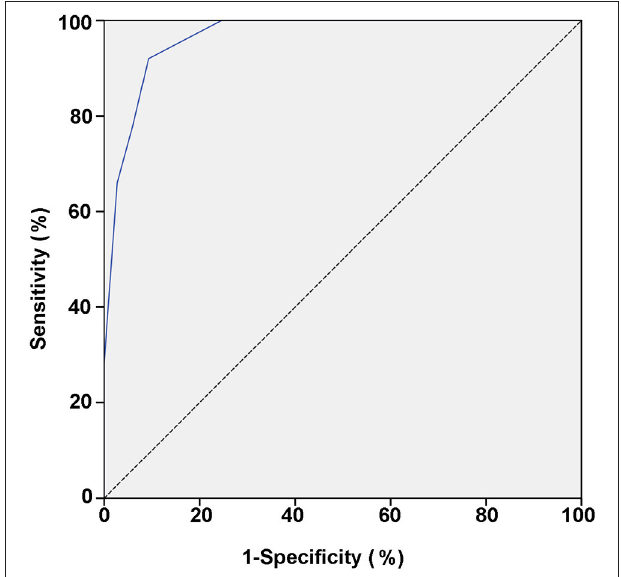
FIGURE 1 | ROC curve of the scoring model between VVS and PPS groups. The vertical and horizontal axes of the curve represent predictive sensitivity and positivity (1-specificity), respectively. The 45 ◦ slash indicates that the sensitivity is equal to the false positive rate, indicating no predictive value. The blue curve represents the ROC curve of the scoring model for the predictive value of the PPS. The AUC represents the predicted value for different cut-off values and it has a value of 0.965 (95% CI: 0.945–0.986; p < 0.01). ROC, receiver operating characteristic; PPS, psychogenic pseudosyncope; VVS, vasovagal syncope; AUC, area under the curve; CI, confidence interval.